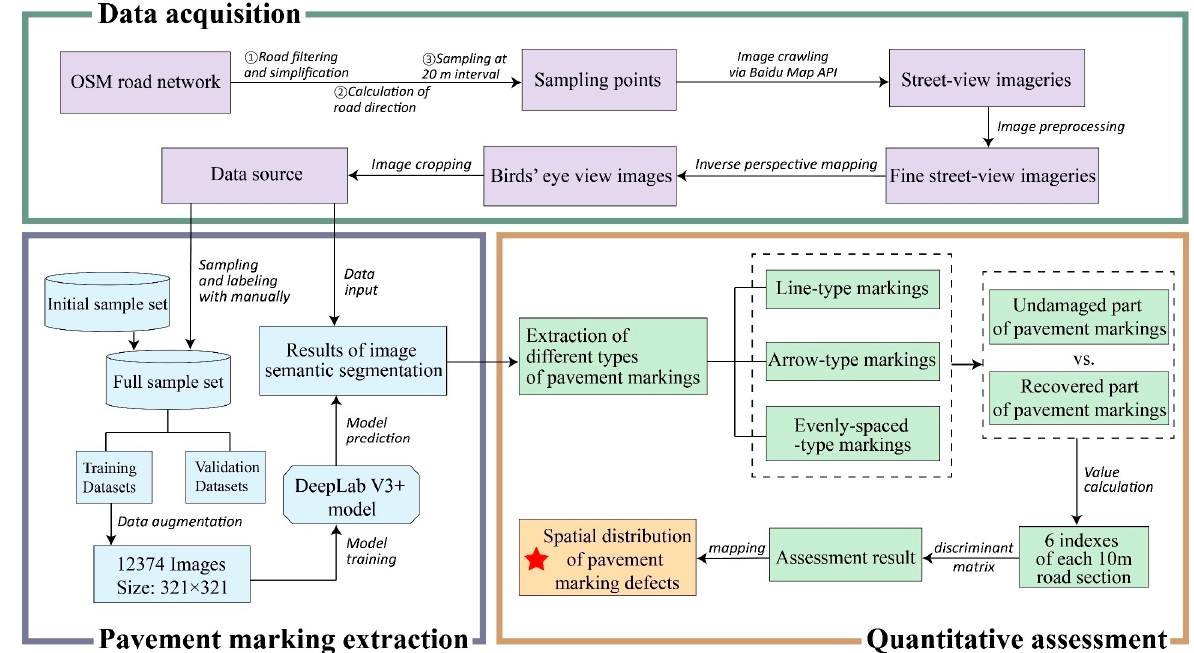
Figure 2. The flowchart of assessing pavement-marking conditions using street-view imageries.